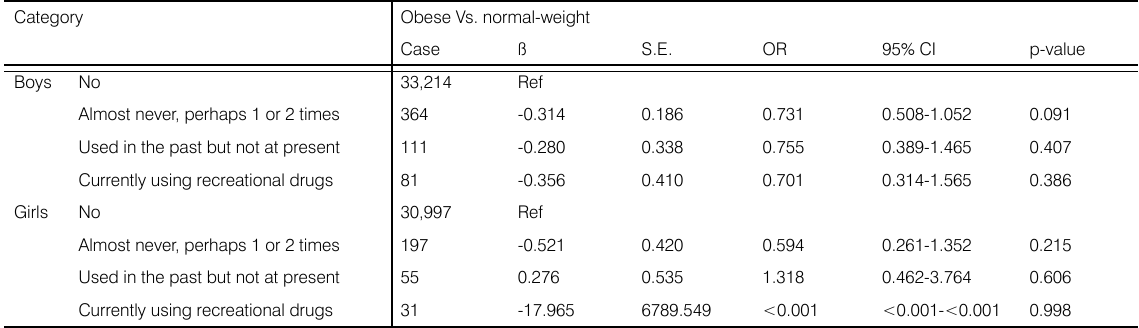
Table 3. The multivariable logistic regression analyses of recreational drug use for the obese and normal-weight groups in Korean Category